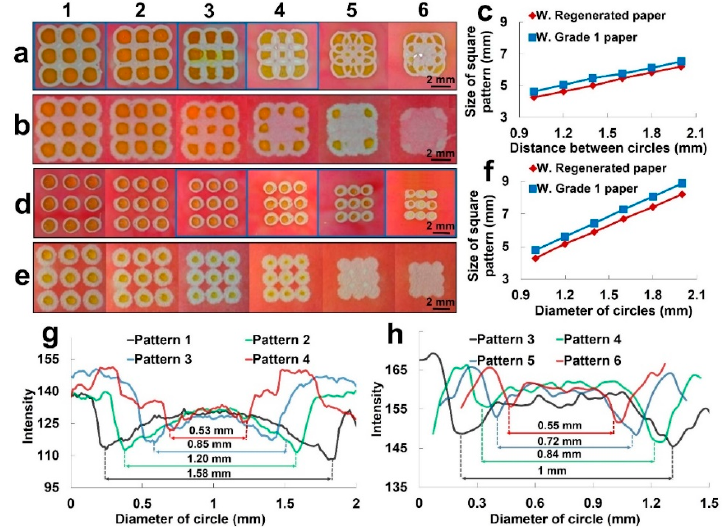
Figure 5. Packing density analysis of closely patterned detection zones. ( a , b ) High-resolution packing of detection zones on Whatman regenerated paper ( a ) and Whatman grade 1 paper ( b ). The diameter of circles in each pattern is 2 mm. The center-to-center distance between adjacent circles starts at 2 mm in the first pattern and decreases by 0.2 mm in each pattern. ( c ) Graph of pattern size versus center-to-center distance between adjacent circles in subfigure a and b ( N = 9 and the error bar shows the standard deviation). ( d , e ) High-resolution fabrication of detection zones on Whatman regenerated paper ( d ) and Whatman grade 1 paper ( e ). The diameter of circles and center-to-center distance in the first pattern is 2 mm and 3 mm, respectively. The diameter of circles and the center-to-center distance between adjacent circles decrease by 0.2 mm and 0.3 mm in each pattern, respectively (the diameter of circles and the center-to-center distance of pattern 6 are 1 mm and 1.5 mm, respectively). ( f ) Graph of pattern size versus diameter of circles of subfigures d and e ( N = 9 and the error bar shows the standard deviation). ( g ) Graph of grayscale intensity analysis of food dye in detection zone of pattern 1–4 of subfigure a. ( h ) Graph of grayscale intensity analysis of food dye in detection zone of pattern 3–6 of subfigure